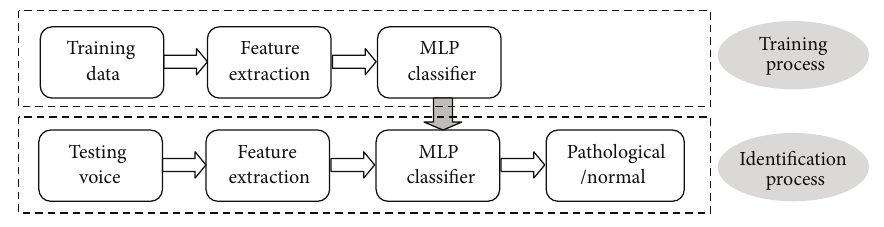
Figure 1: Block diagram of the proposed